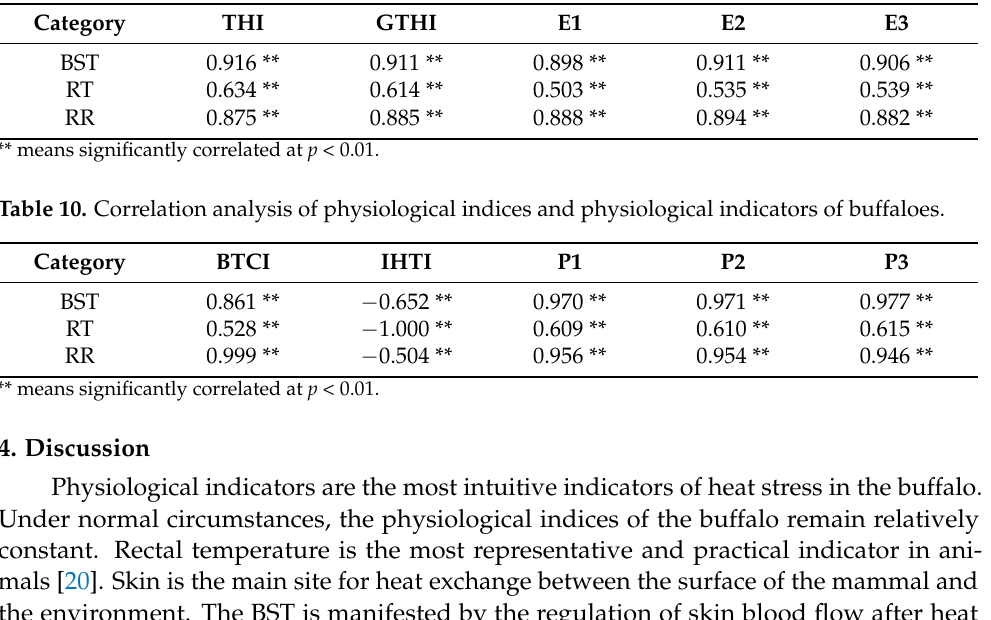
Table 9. Correlation analysis of environmental indices and physiological indicators of buffaloes. Category THI GTHI E1 E2 E3 BST